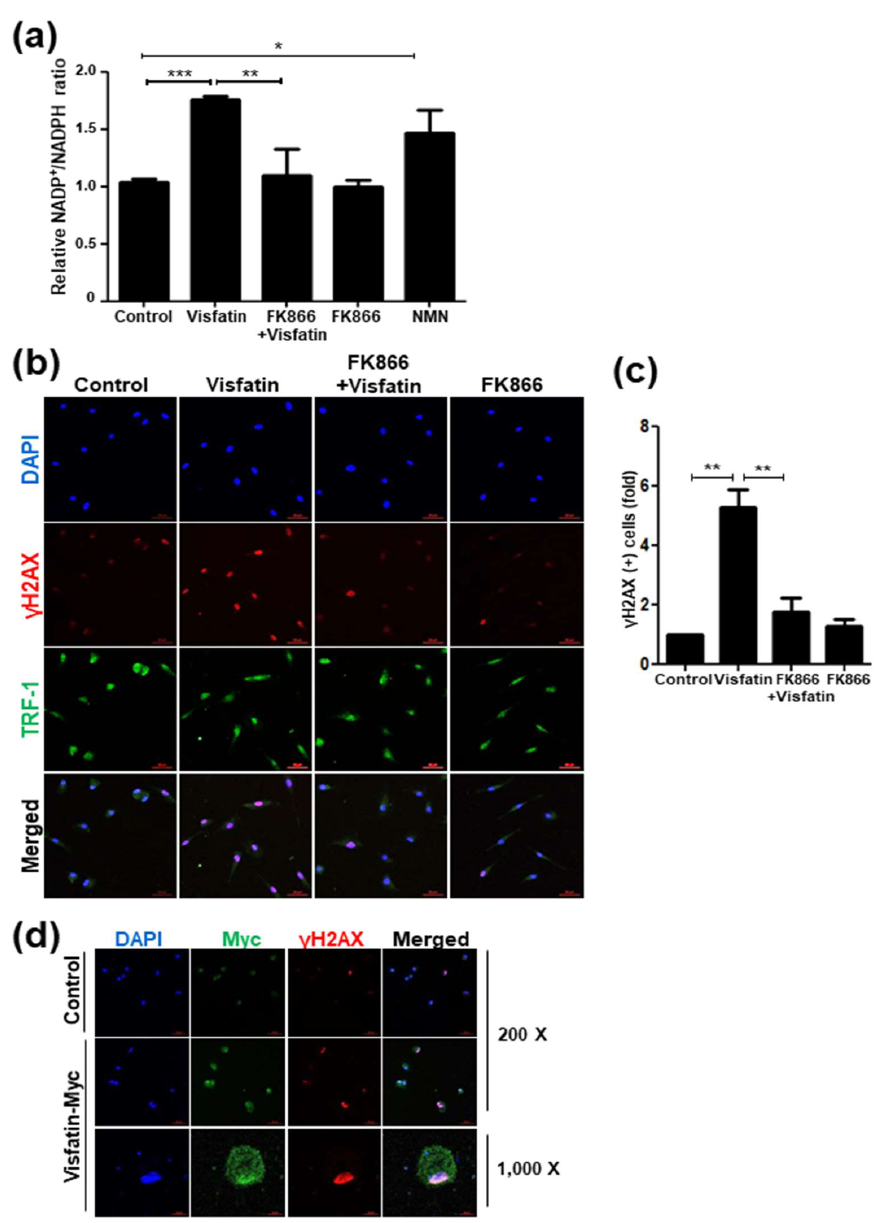
Figure 6. Visfatin increases NADPH consumption and induces telomere damage. Human dental pulp cells (hDPCs) were pretreated with FK866 (10 µ M) for 2 h and then incubated with visfatin (500 ng / mL) for 24 h. ( a ) Measurement of the NADP / NADPH ratio in visfatin-treated hDPCs with or without FK866 pre-treatment. Nicotinamide mononucleotide (NMN, 100 µ M), the product of the visfatin / Nampt enzymatic reaction, was used to compare its activity in NADPH consumption. ( b ) Immunofluorescence analysis of TRF-1 (Alexa fluoro (AF)-488, green) and γ H2AX (AF-594, red) in hDPCs. The cells were analyzed using a confocal microscope. Nuclei were counterstained with DAPI (blue). Scale bar: 50 µ m. ( c ) Quantification of the percentage of γ H2AX-positive cells. ( d ) hDPCs were transiently transfected with a vector mediating the overexpression of visfatin (pCI-Visfatin-Myc) for 48 h and subjected to immunocytochemical analysis. Cells were stained using anti-Myc antibody (green) and anti- γ H2AX (red). Nuclei were counterstained with DAPI (blue). Scale bar: 50 µ m. * p < 0.1, ** p < 0.01, *** p <